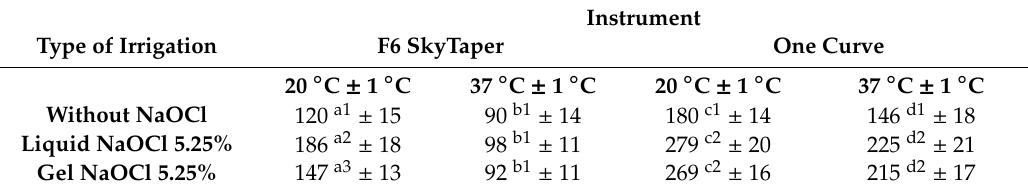
Table 1. Time to Fracture in Seconds of Each Group as the Mean ± Standard Deviation.